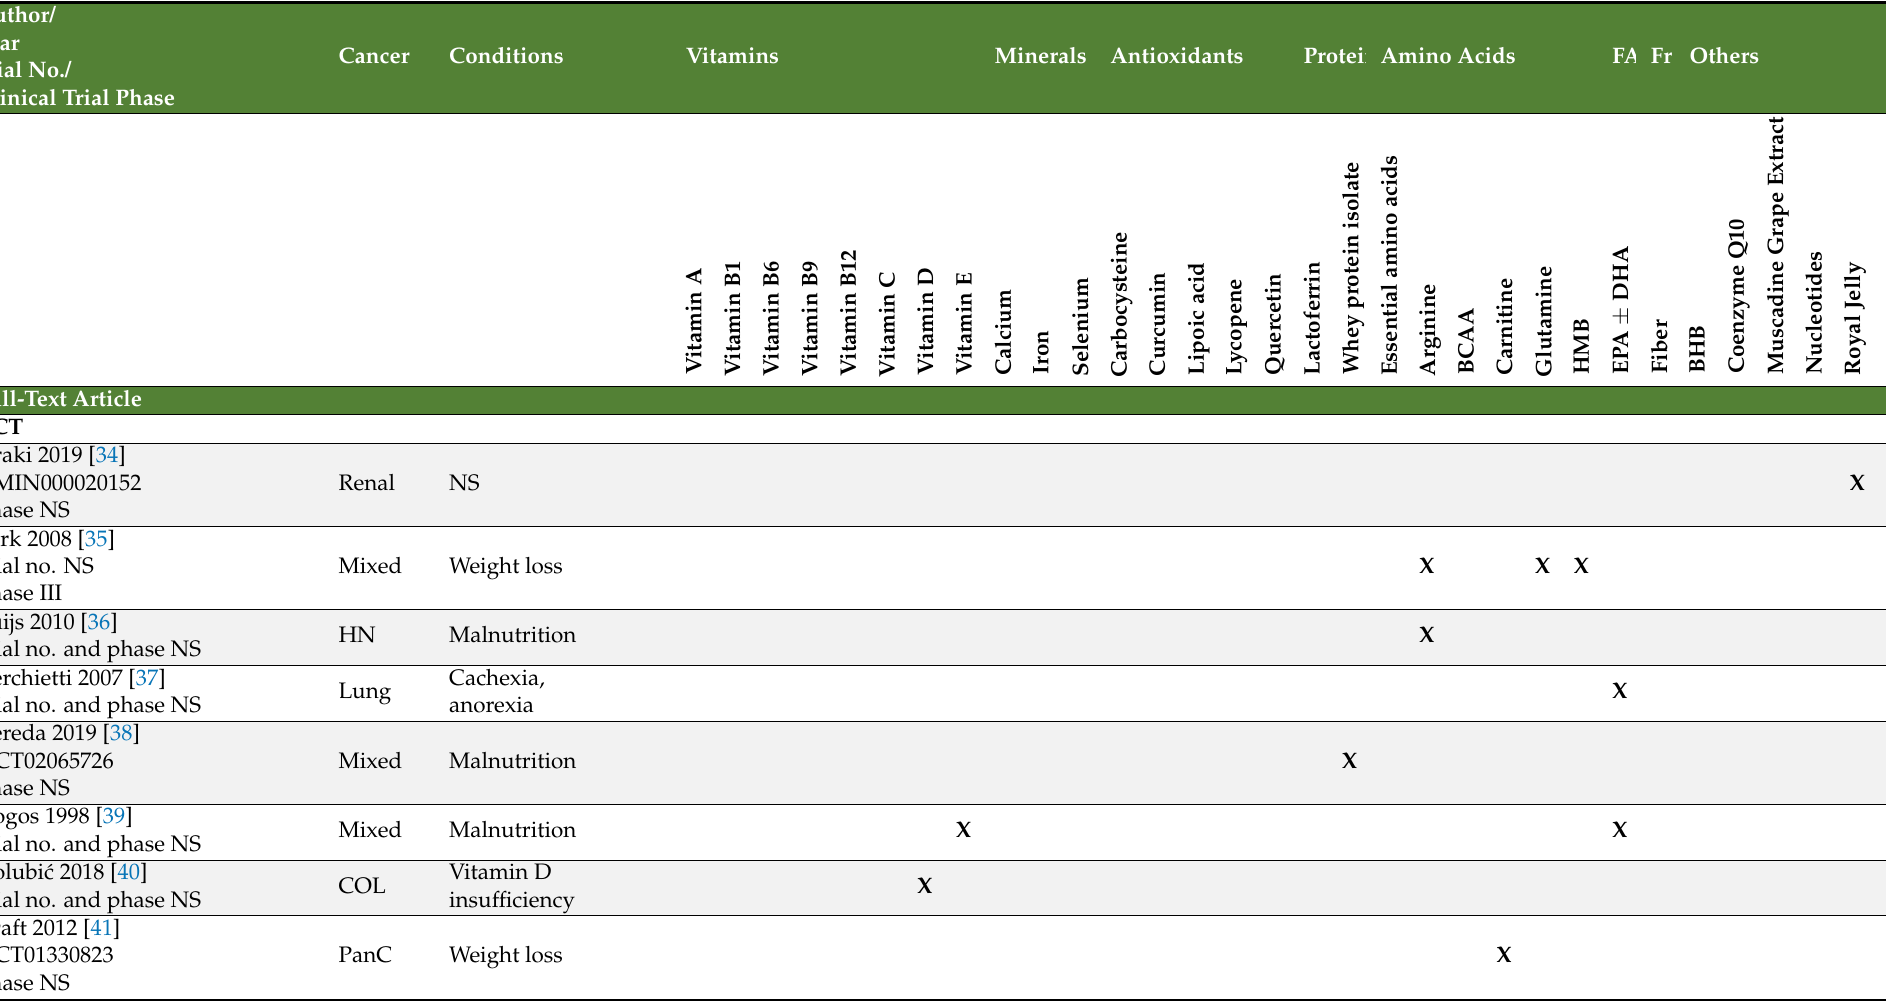
Table 3. Types of dietary supplements, cancers, and malnutrition-related conditions included in each of the